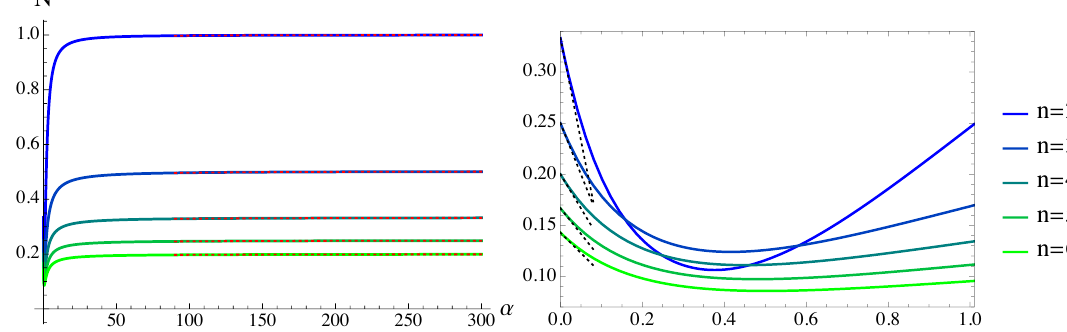
Figure 4 . Relative tension vs. α . Numerical results are plotted by solid curves for each dimension. Red dotted curves are the fitting curves in eq. (6.3) for n > 2 and eq. (6.7) for n = 2 . The right panel is a closeup of the small parameter region. Black dotted curves are the linear approximation